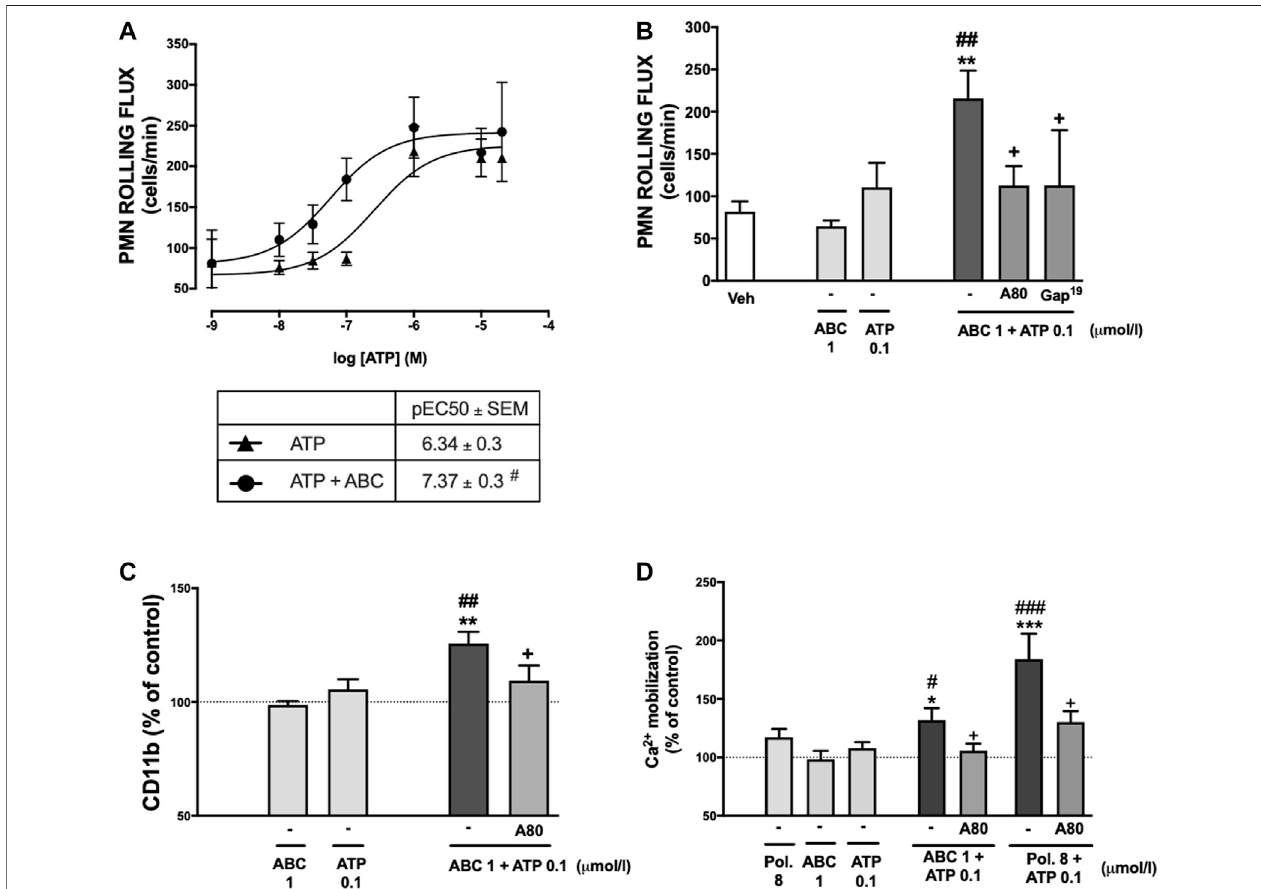
FIGURE8| PotentiationbyABCoftheeffects ofATPonPMN-endothelialcellinteractions,theexpression ofCD11b andoncalcium in fl ux.HUVECand PMNwere treated (4 h) with ATP (0.001 – 20 µmol/L) in the presence or absence of ABC (1 µmol/L) and PMN rolling fl ux (A) was analyzed. Doses of ABC (1 µmol/L) and ATP (0.1 µmol/L) were selected to treat individually or in combination both PMN and HUVEC or whole blood. In some cases, both HUVEC and PMN or whole blood were pretreated with A804598 (A80, P2X7R antagonist, 1 μ mol/L, 30 min) prior to ABC (1 µmol/L) and ATP (0.1 µmol/L). PMN rolling fl ux (B) was quanti fi ed after assemblingthe fl owchamberandtheexpressionofoneofthetwosubunitsofMac-1CD11b (C) onneutrophilswasquanti fi edby fl owcytometry. (D) PMNsweretreated (1 h) with Polymyxin B (Pol. 8 µmol/L), ABC (1 µmol/L) and ATP (0.1 µmol/L) individually or in combination and, in somes cases, PMN were pretreated with A804598 (A80,P2X7Rantagonist,1 μ mol/L,30 min)priortoPolymyxinB(Pol.8 µmol/L)andATP(0.1 µmol/L)orABC(1 µmol/L)andATP(0.1 µmol/L).Calciummobilizationwas quanti fi edby fl owcytometry. Fluorescencevaluesareexpressed asapercentage ofmean fl uorescenceintensitiesofcontrolcells(dotted line).Resultsaremean ±